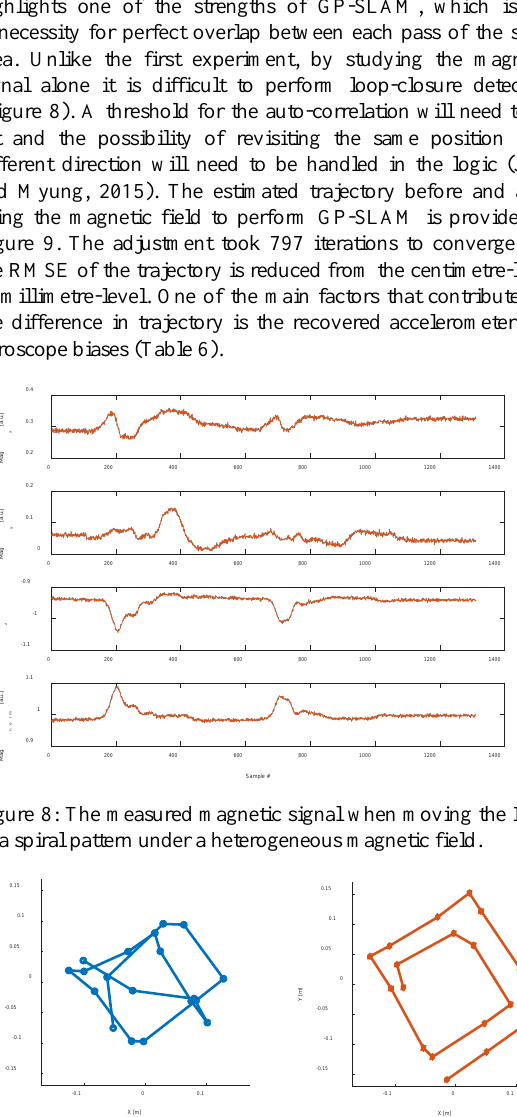
Figure 9: The reconstructed spiral trajectory. (Left) before GP- SLAM in blue and (Right) after GP-SLAM in orange.